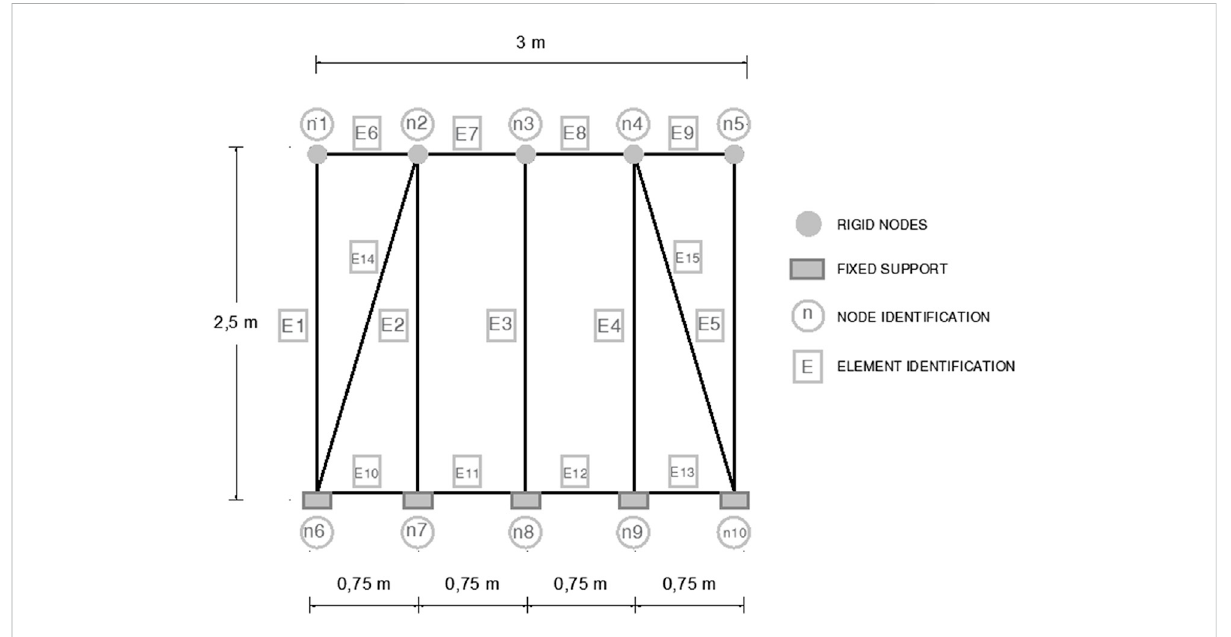
FIGURE 10 Framework panel discretization.